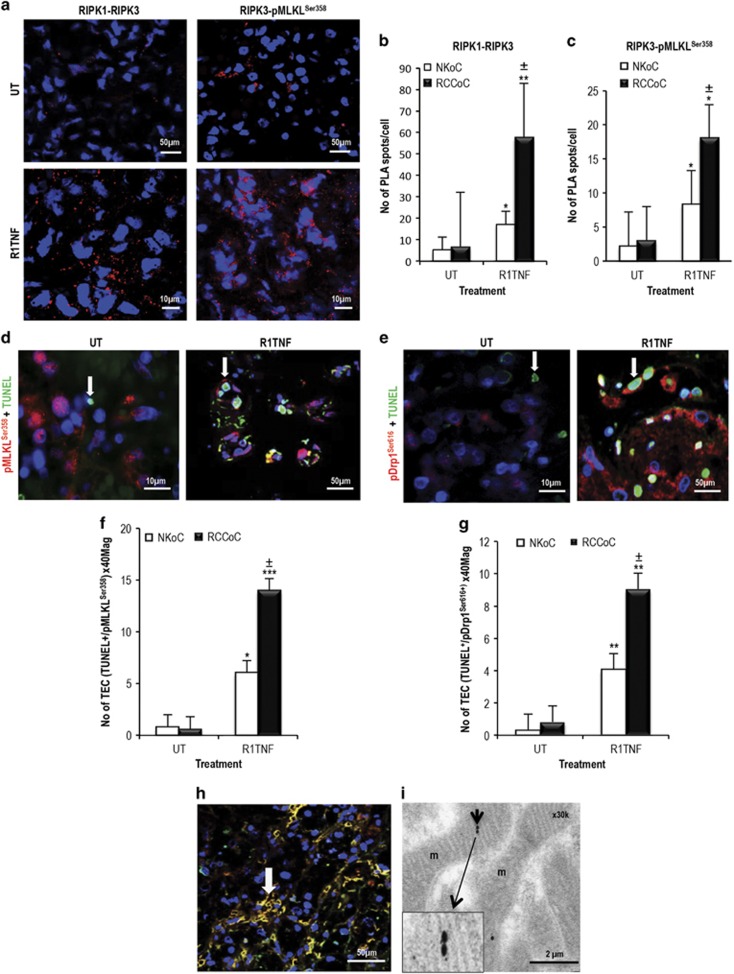
PLA of organ culture of RCC grade 1. (a) In comparison with untreated controls (UT), R1TNF induced a strong interaction of RIPK1-RIPK3 and RIPK3-pMLKLSer358 appearing as strong red fluorescence spots mainly within the cytoplasm of mTECs. Each individual interacting protein pair observed as a red spot by confocal microscopy is expressed as the number of signals/cell (PLA spots/cell). (b and c) Quantification of PLA spots in TECs in the two study groups; RCC (RCCoC) and normal kidney (NKoC) show a statistically significant difference, more pronounced in RCCoC. **P<0.01 versus UT, *P<0.05 versus UT, ±P<0.05 versus R1TNF (NKoC). (d and e) Representative confocal images of pMLKLSer358 or pDrp1Ser637 and TUNEL in organ cultures of RCC grade 1. Compared with UT cultures, R1TNF induced an increase in the level of TUNEL+mTECs (green) associated with pMLKLSer358 and pDrp1Ser616 (red) expression (arrows). (f and g) Quantification of TUNEL+mTECs/pMLKLSer358+ and TUNEL+mTECs/pDrp1Ser616+ shows statistical significant differences between cultures. ***P<0.0001 versus UT, **P<0.001 versus UT, *P<0.01 versus UT, ±P<0.05 versus R1TNF (NKoC). (h) Combined immunofluorescence of R1TNF-treated cultures shows co-localization of pMLKLSer358 and pDrp1Ser616 in mTECs (arrow). (i) Immunogold electron microscopy demonstrate close proximity of gold particles for pMLKLSer358 (5 nm) and pDrp1Ser616 (15 nm) in mitochondria (m) (inset zoomed × 2.5). Bars=mean±S.E.M.; images are representative of n=3 independent experiments from six separate organ culture experiments with similar results